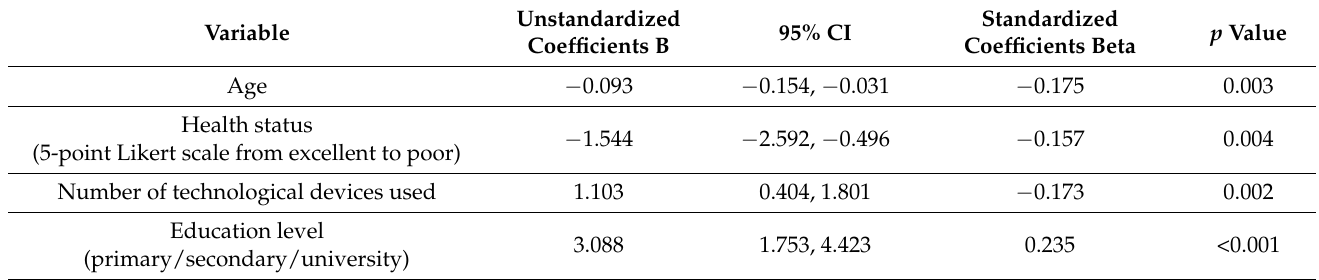
Table 3. Predictors of eHealth literacy of Chinese immigrants (adjusted)